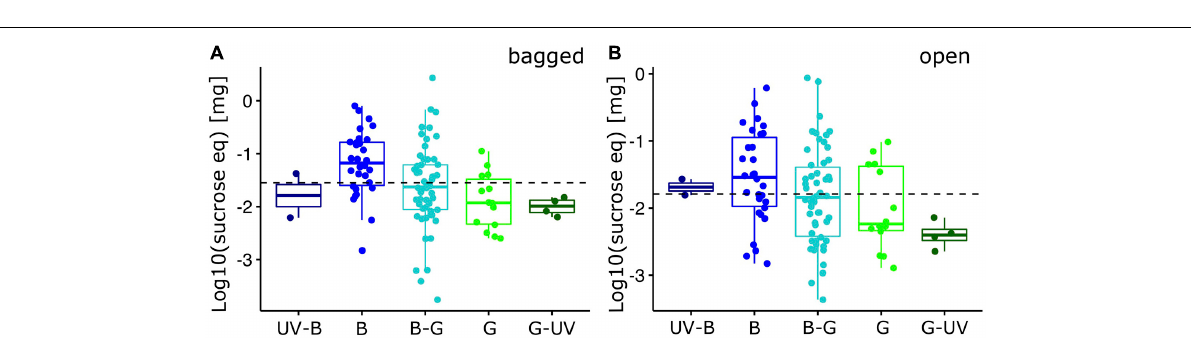
Reward quantity of bagged flowers differed significantly between the color categories for the maximum nectar reward